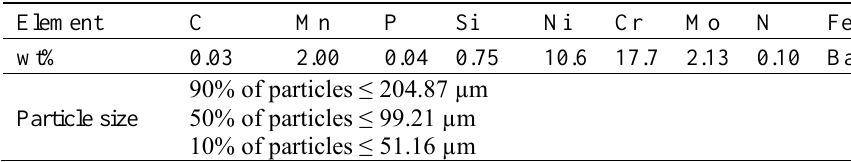
Table 1. AISI 316L powder characteristics.